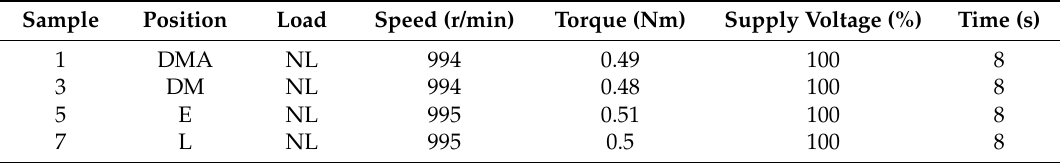
Table 3. Characteristics of the experiments for the healthy motor at steady state.